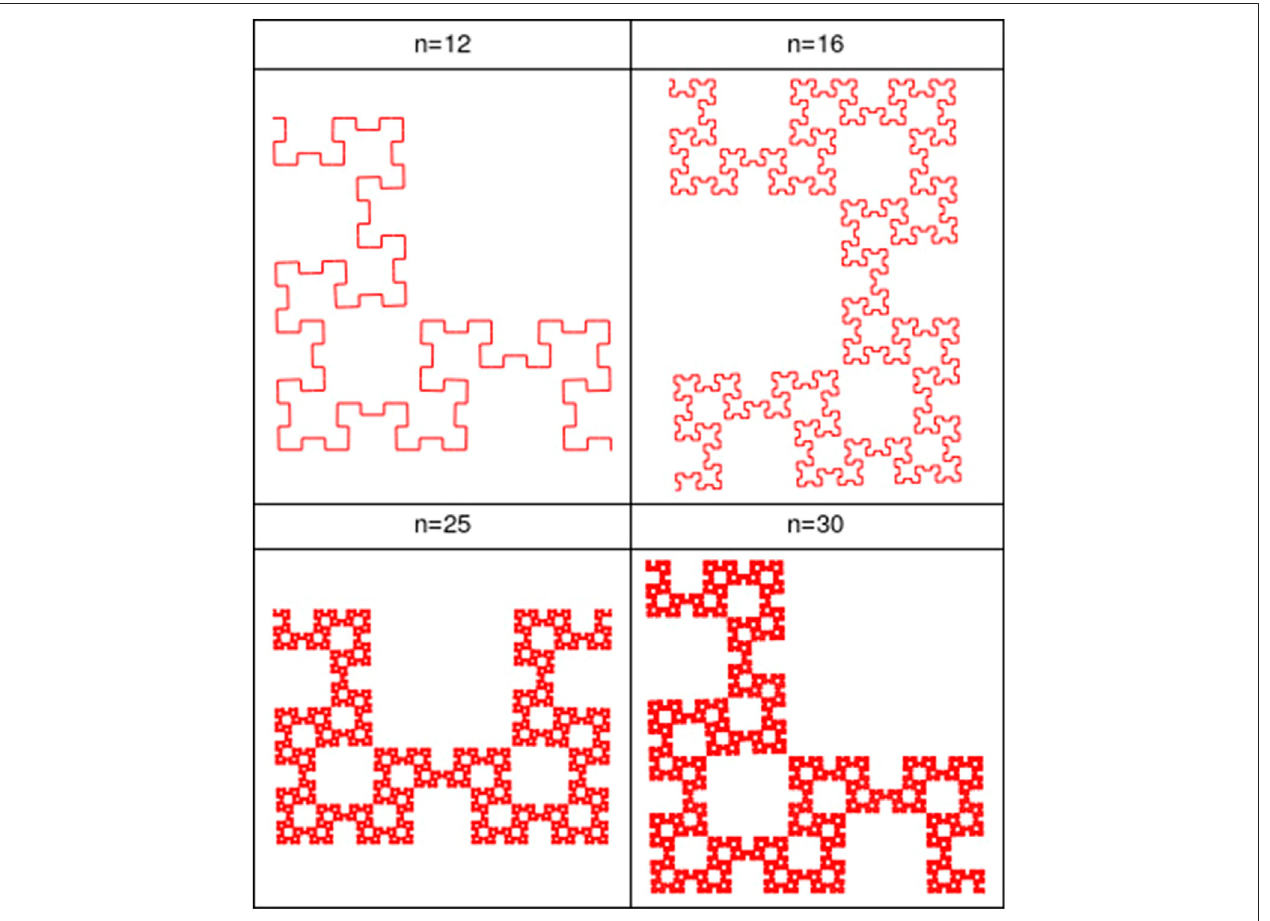
FIGURE3| TheFibonacciWordFractalforaturningangle θ ≈ 0 . 9902 π .ThiscurvehasHausdorffdimension φ .Theresultisalmostindistinguishablefromthatof θ (cid:2) 2 π /2. However, if we select n (cid:2) 30 and we follow the trajectory around the big white square, we see that the cumulative effects are such that the trajectory does not close.